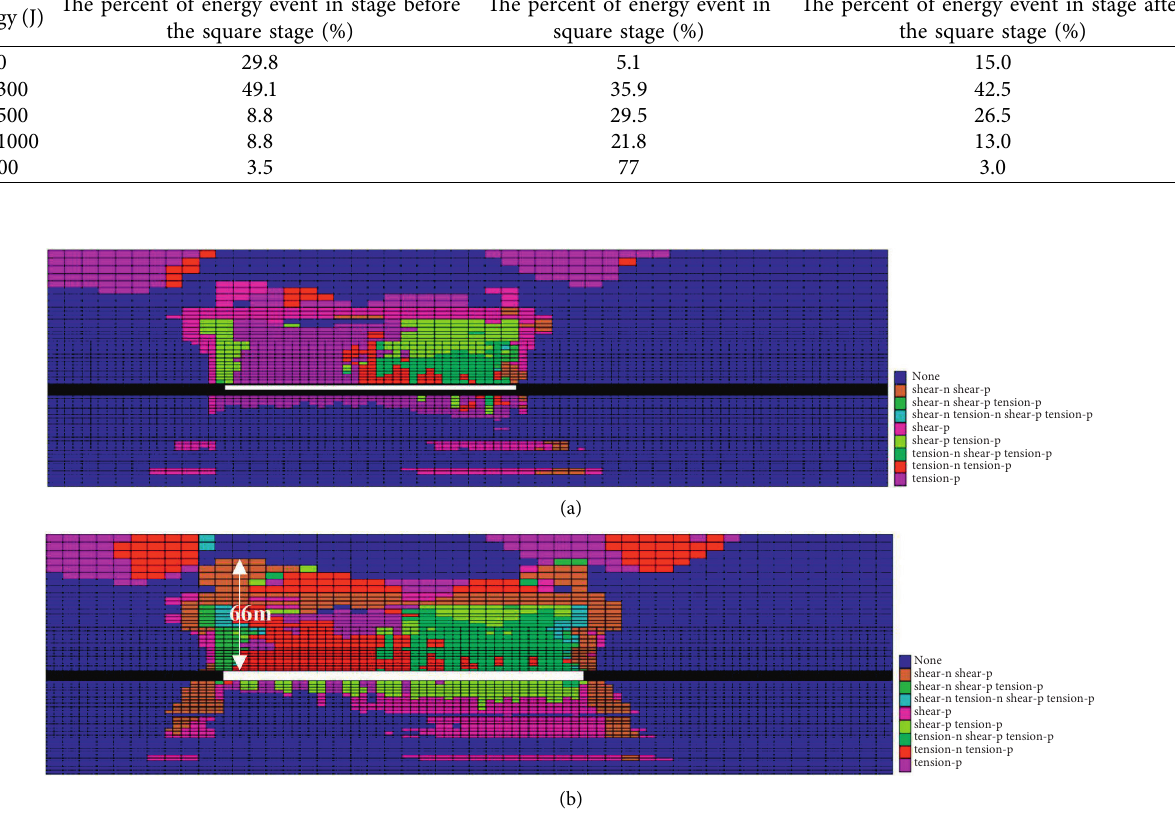
Figure 10: Plastic distribution diagram: (a) the stage before the square stage; (b) the square